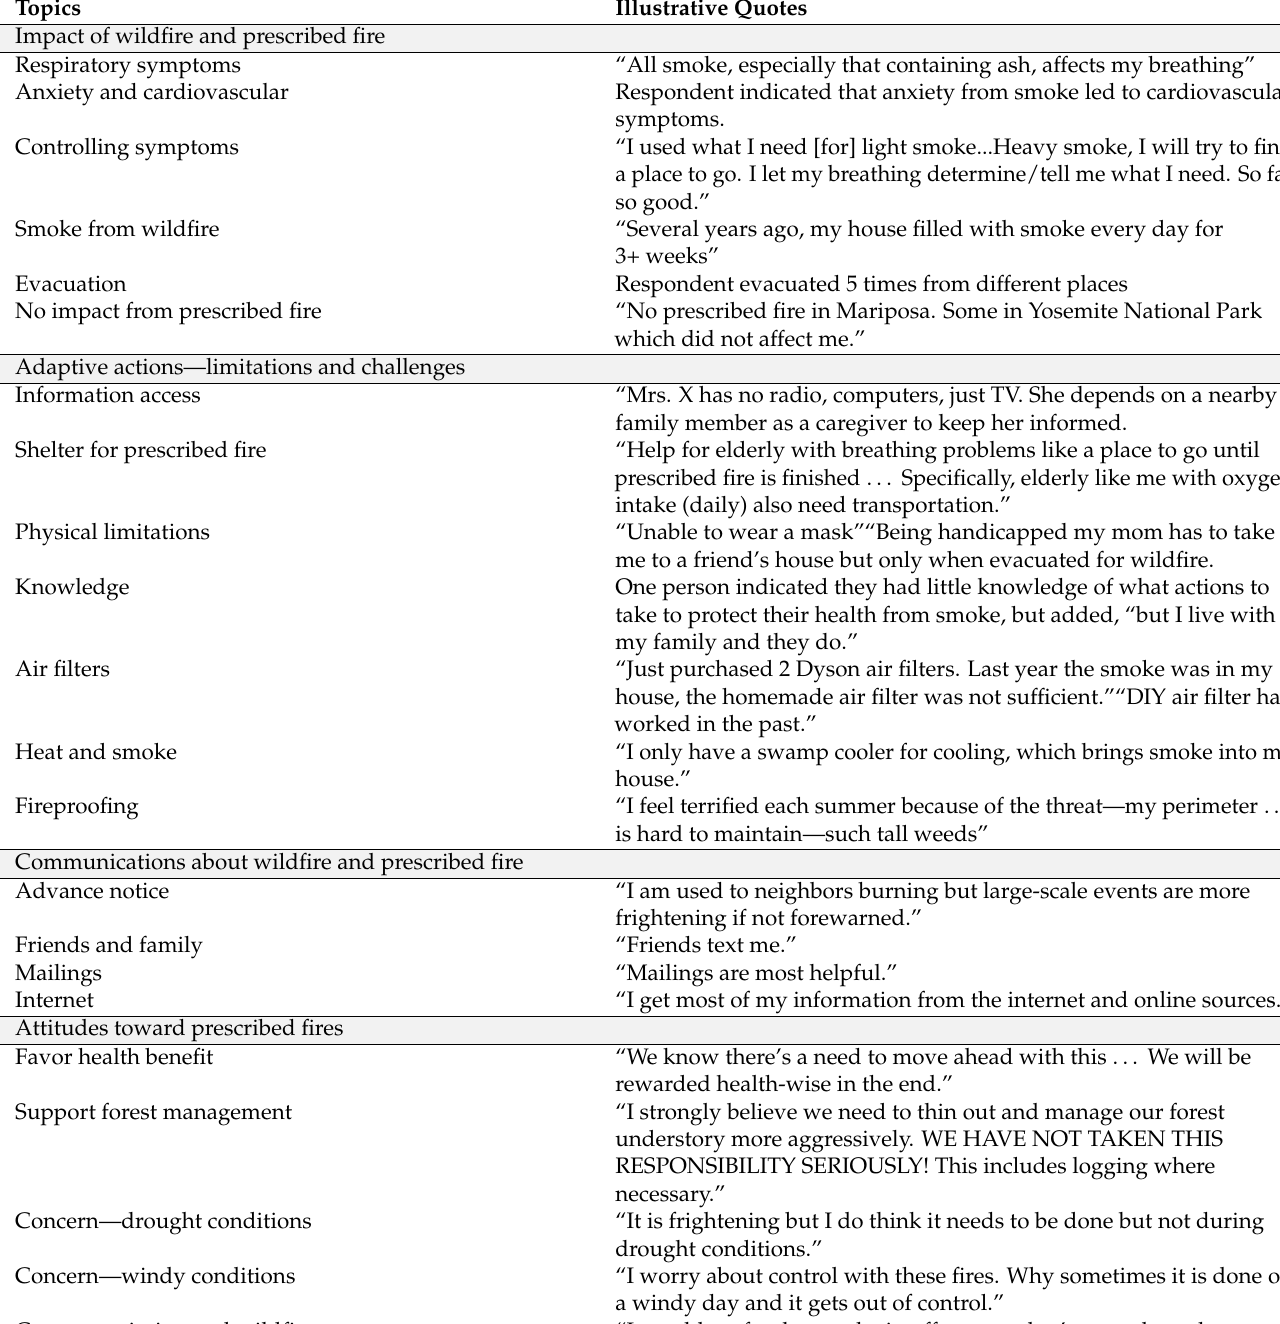
Table 4. Qualitative data on residents’ experiences with wildfires and prescribed fires from a survey of a medically vulnerable adult population, Mariposa County, California, 2021 a